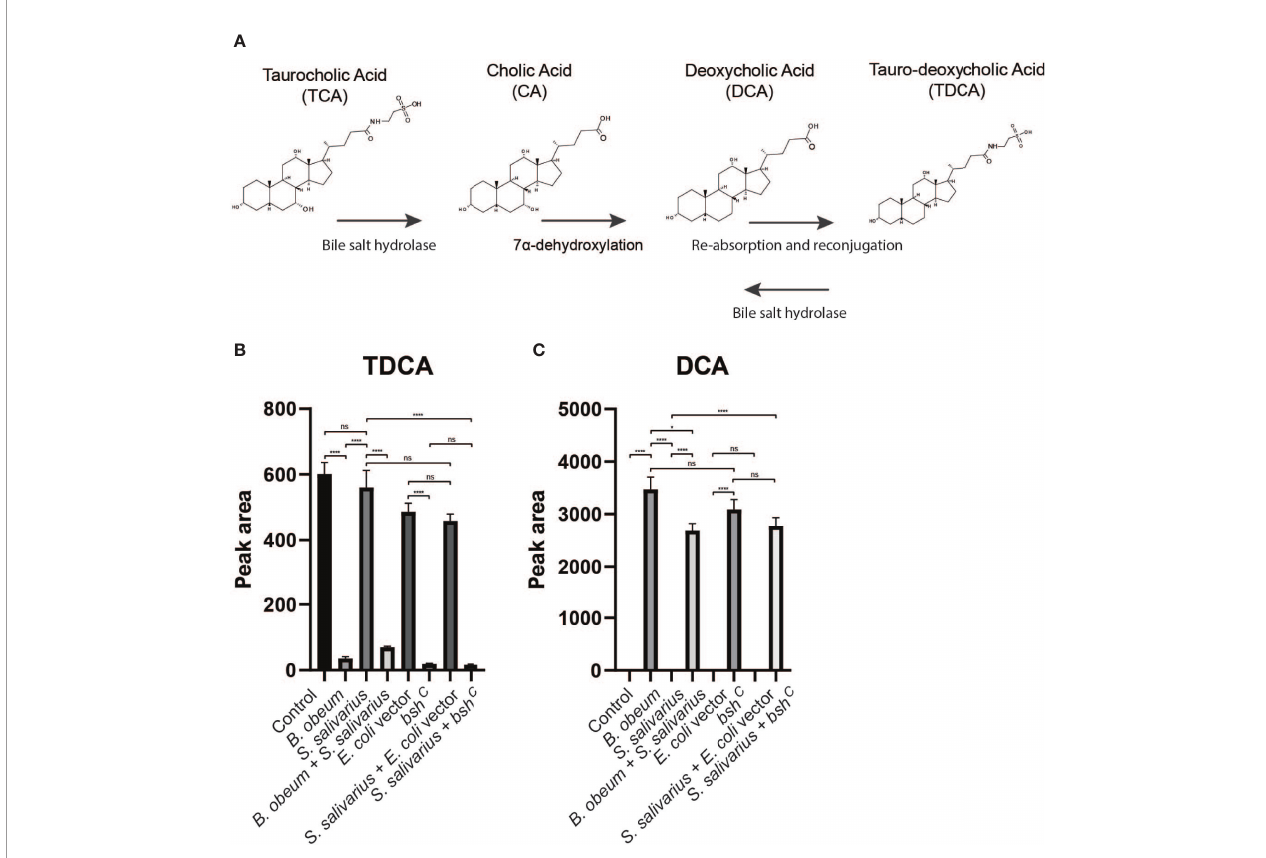
FIGURE 5 | Bile salt hydrolase-dependent TDCA and DCA levels in infant mouse intestines. (A) Model of microbial modi fi cation of bile salt in the gut. (B) Tauro- deoxycholate (TDCA) and (C) deoxycholate (DCA) levels in intestinal homogenates after incubation with indicated strains. (n = 4, t test, *P < 0.05; ****P < 0.0001; ns, not signi fi